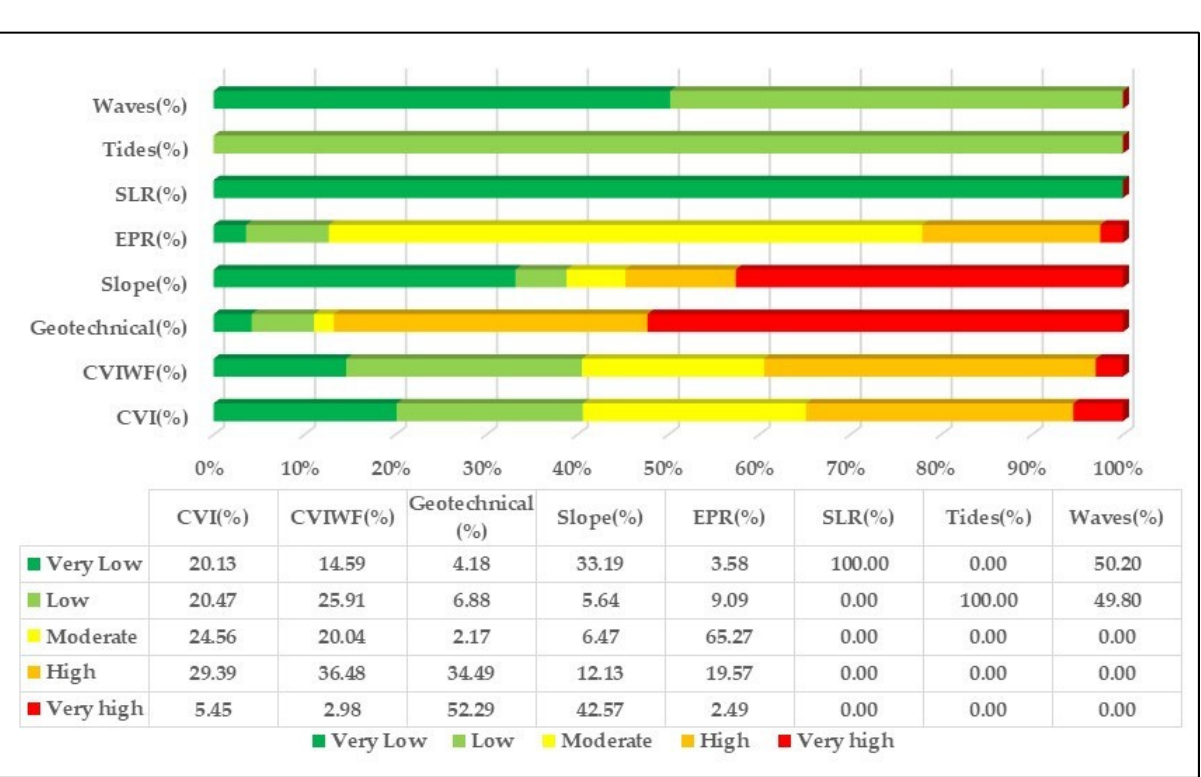
Figure 5. Percentage in each vulnerability class in relation with the CVI and CVI WF model applied in the research area. In general, with the insertion of a weighted factor in the geotechncial parameter, an increase was observed in the low vulnerability class (CVI Class 2) and the high vulnerability class (CVI Class 4). At the same time, a decrease was observed in the very low vulnerability class (CVI Class 1), the moderate vulnerability class (CVI Class 3) and the very high vulnerability class (CVI Class 5) (Figure 6).